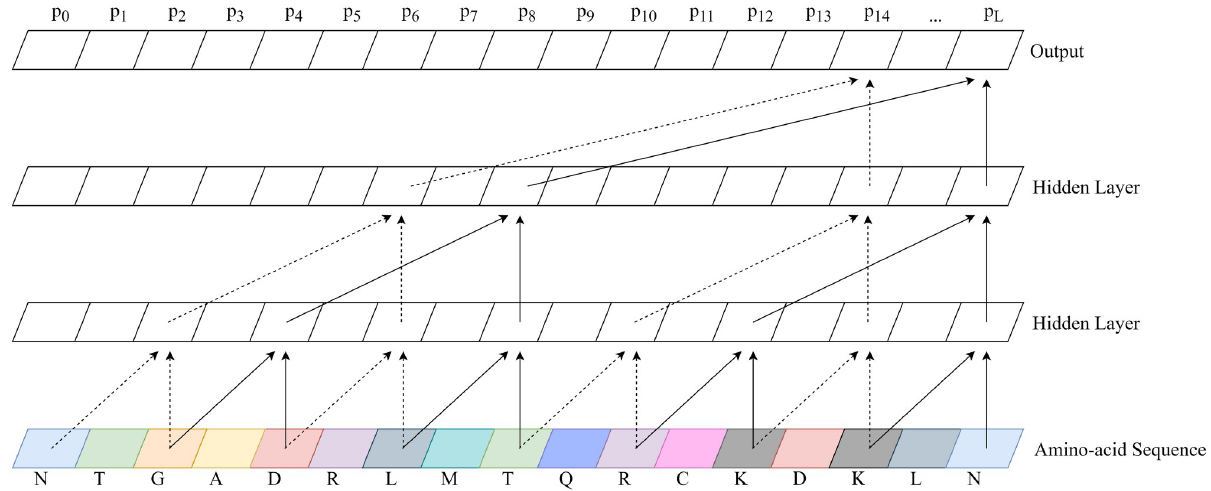
Fig 1. Example temporal convolutional network. A temporal convolutional network (TCN) with 2 hidden layers and a convolutional kernel size of 2. The number of connections exponentially increases as hidden layers are added, enabling a wide receptive field. Notice the output of a TCN is the same length as the input. Balrog’s TCN used 8 hidden layers, a convolutional kernel size of 8, a dilation factor of 2, and 32 � L hidden units per layer where L is the length of the amino-acid sequence.